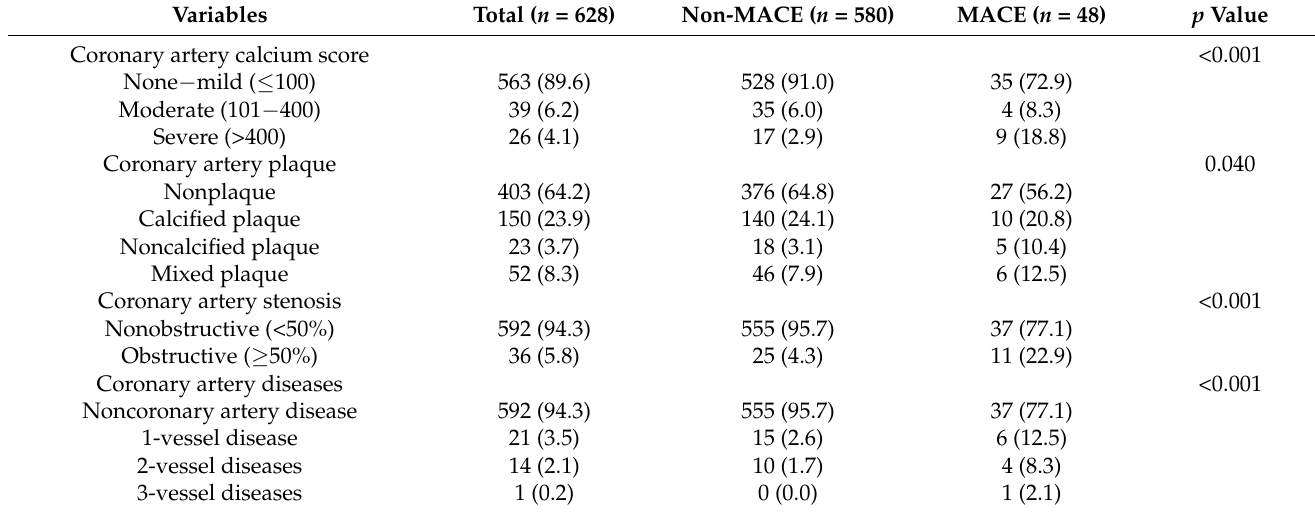
Table 4. Preoperative findings of the coronary computed tomographic angiography of liver transplant recipients according to the major adverse cardiac events that